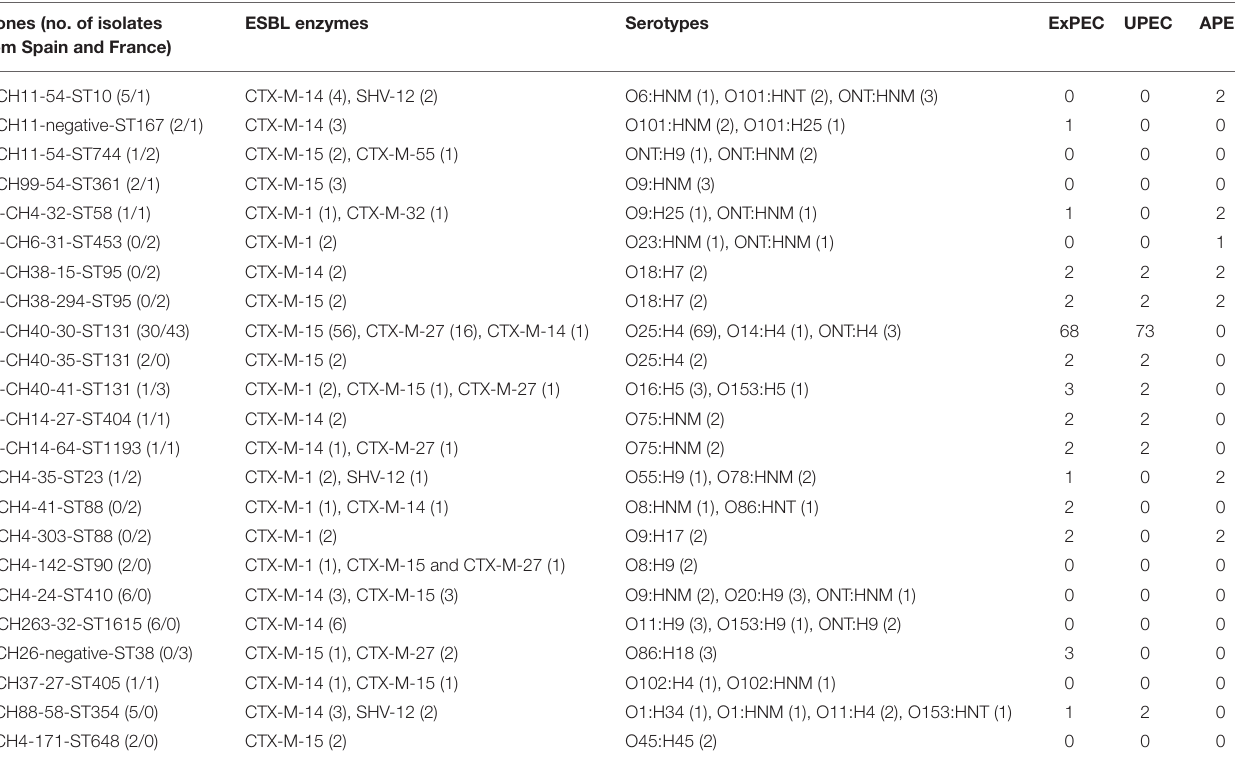
TABLE 3 | ESBL enzymes, serotypes and ExPEC, UPEC and APEC status according to the clones including at least two isolates. Clones (no. of isolates ESBL from Spain and France)